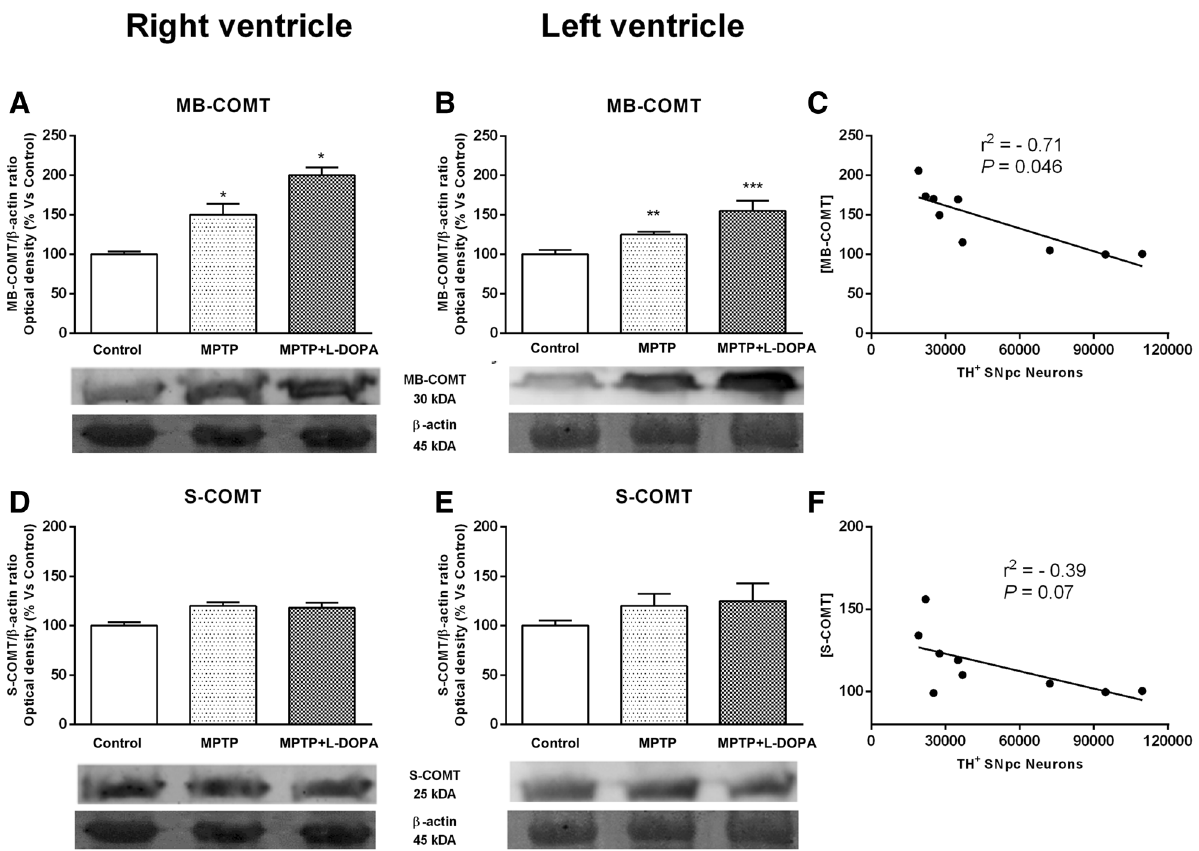
Figure 4. Effects of MPTP and L-DOPA treatment on COMT in the monkey heart. ( A , B ) MB-COMT/β-actin ratio (optical density, % vs control) in controls, MPTP-treated monkeys and in the MPTP + L-DOPA group. MB-COMT expression was increased in the RV of MPTP- and MPTP + L-DOPA-treated animals compared to control group. ( C ) Significant correlation between MB-COMT and TH+ neurons in the SNpc (r 2 = 0.71, P = 0.0046). ( D , E ) S-COMT/β-actin ratio (optical density, % vs control) in controls, MPTP-treated monkeys and in the MPTP + L-DOPA group. The quantitative analysis showed no differences between groups. ( F ) No correlation between S-COMT and TH+ neurons in the SNpc was observed. Data were compared by one- way ANOVA (MB-COMT: F (2,9) = 14.41, P = 0.0016, RV; F (2,9) = 11.62, P = 0.0032, LV. S-COMT: F (2,9) = 3.31, P = 0.0827, RV; F (2,9) = 1.742, P = 0.2293, LV) followed by Newman–Keuls post-hoc test. Values are represented as mean ± standard deviation. (*P < 0.05, **P < 0.01, ***P < 0.001 versus control group). MB membrane, S soluble, COMT catechol-O-methyl transferase, MPTP 1-methyl-4-phenyl-1,2,3,6-tetrahydropyridine, L-DOPA levodopa. (n = 4 animals/group and 2 technical